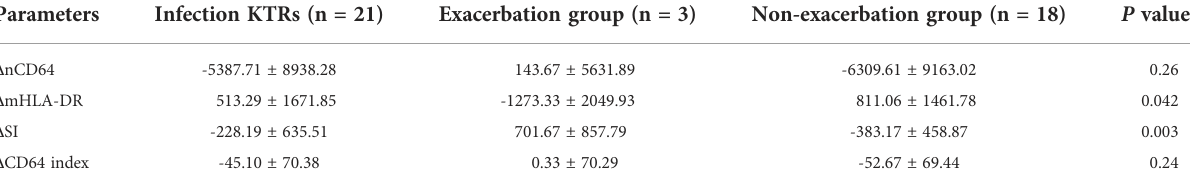
TABLE 5 The dynamic changes of nCD64 and mHLA-DR expression related to the prognosis of the infection KTRs.